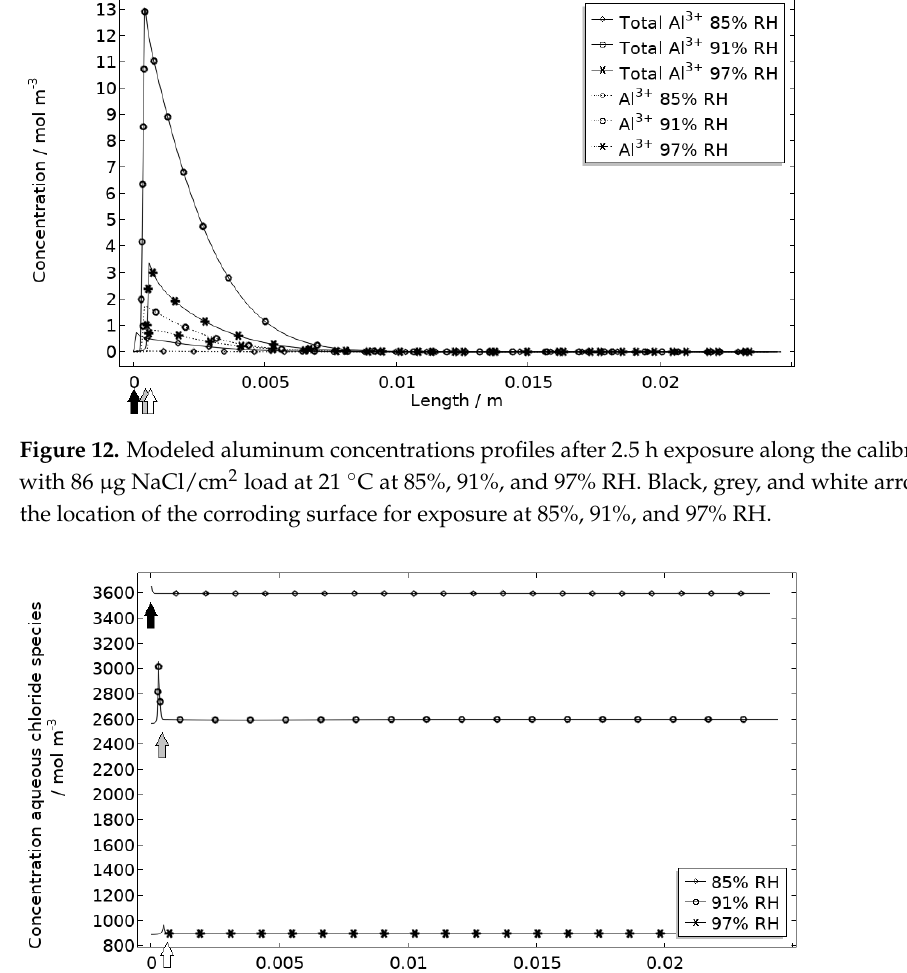
Figure 13. Modeled aqueous chloride concentration profiles after 2.5 h exposure along the calibration cell with 86 µ g NaCl/cm 2 load at 21 ◦ C at 85%, 91%, and 97% RH. Black, grey, and white arrows mark the location of the corroding surface for exposure at 85%, 91%, and 97% RH.